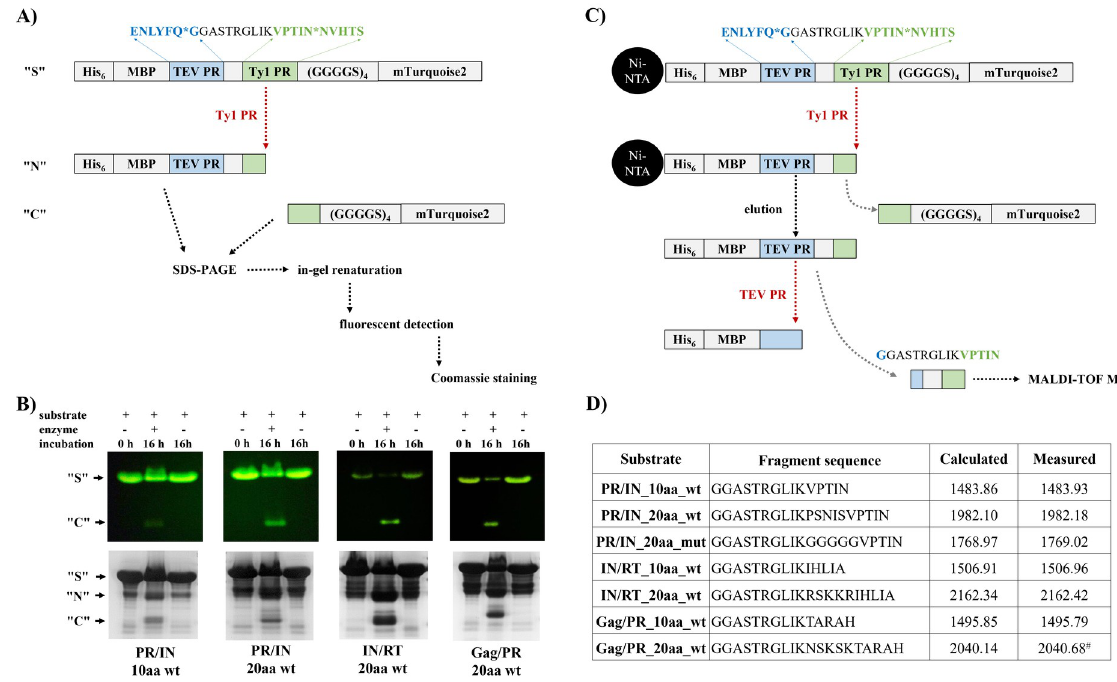
Fig 5. Cleavage reactions by fluorescent recombinant protein substrates. (A) Schematic representation of a recombinant fusion protein substrate and scheme of in-solution cleavage reactions. The TEV PR and Ty1 PR cleavage sites are colored by red and green, respectively. Cleavage site sequences are also shown for both proteases, asterisks indicate cleavage position. Red arrow shows cleavage by Ty1 PR, upon cleavage of the substrate (“S”), N- and C-terminal cleavage products (“N” and “C”, respectively) are produced. After enzymatic digestion, the cleavage products and uncleaved substrates can be separated by denaturing SDS-PAGE. Proteins can be visualized after in-gel renaturation of fluorescent proteins by blue light transillumination or by Coomassie staining. (B) Representative gel images are shown for substrates containing PR/IN, IN/RT, and Gag/PR cleavage sites, after cleavage reactions the bands were visualized in the polyacrylamide gels by blue light transillumination (upper gel images) and by Coomassie staining (lower gel images), as well. (C) The workflow of cleavage site identification, which includes a cleavage reaction with Ty1 PR, the separation of the cleavage fragments, and the digestion of N-terminal cleavage fragment by TEV PR. Resulted short fragments can be subjected to MALDI TOF-MS analysis. The recombinant substrate is identical with that one shown in figure part A, but here we show its immobilization to magnetic affinity beads (Ni-NTA). (D) The molecular weights (Da) of proteolytic fragments were calculated by ProtParam tools of ExPASy (available at https://web.expasy.org/protparam), and were compared to [M+H] + values (Da) determined by MALDI-TOF MS. # denotes detection with low